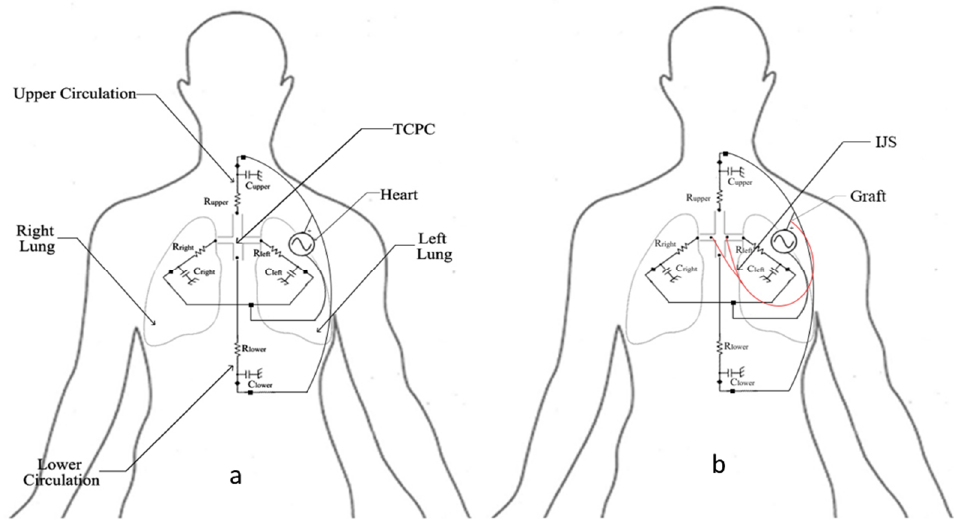
Figure 4. ( a ) LPM representation of Fontan physiology and ( b ) Fontan physiology with Figure 4. ( A ) LPM representation of Fontan physiology and ( B ) Fontan physiology with IJS Table 1. Vascular compliance of sections.